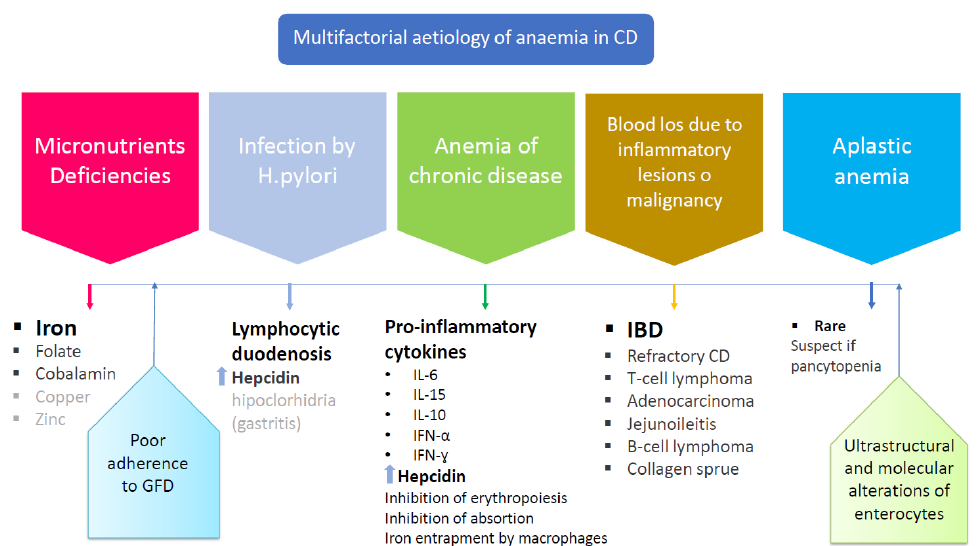
Figure 4. Factors influencing the development of anemia in CD. The main and most frequent cause of anemia in CD is malabsorption. The figure illustrates other components that may contribute to its pathogenesis to a lesser extent. CD “celiac disease”; GFD: “gluten free diet”; IBD: “inflammatory bowel disease”.